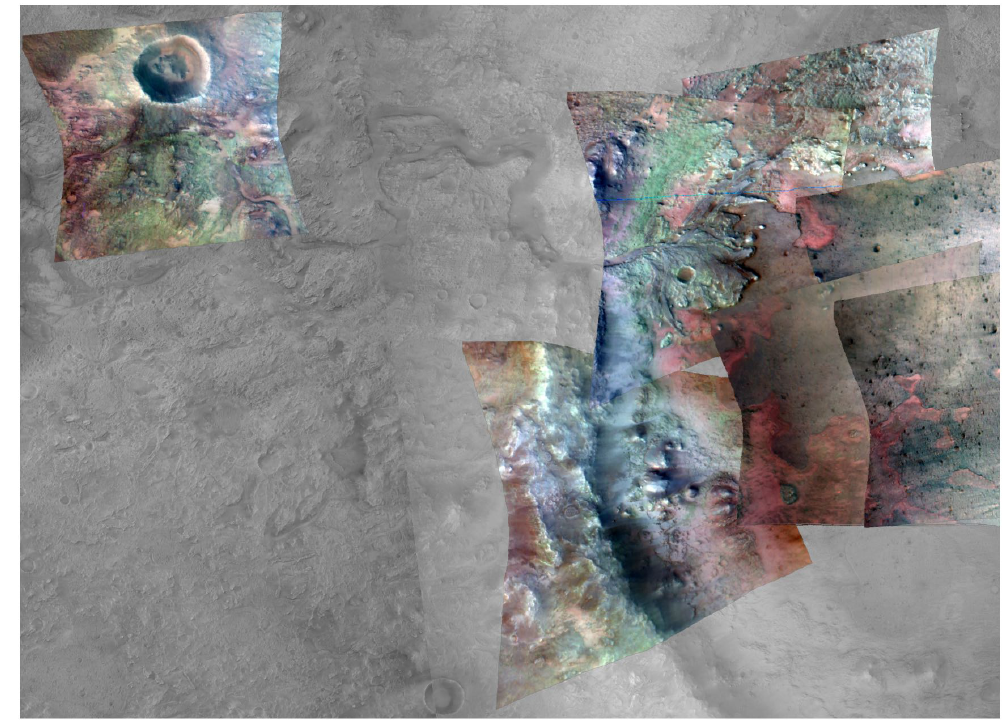
Figure 5. Jezero crater with multiple CRISM observations overlaid on CTX